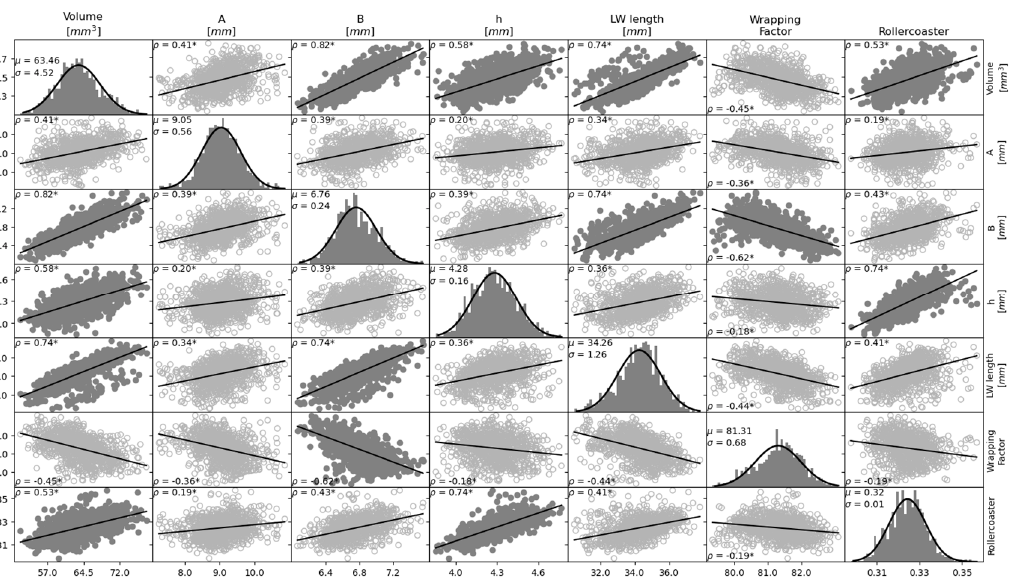
Figure 2. Population statistics and correlation plots between anatomical features of the cochlea. Histograms of the parameters with fitted Gaussian curves are shown in the diagonal of the matrix. Scatter plots show the correlation between the parameter indicated in the column titles and the parameter in the row titles. A strong correlation ( ρ > |0.50|) between parameters is represented by scatter plots with filled circles and a weak correlation is shown by empty circles. Solid lines indicate the linear regression curves. Note that the scales of the y-axes do not apply to the histograms. ρ : Pearson correlation coefficient; µ : mean; σ : standard deviation; * depicts a significant correlation ( p -value <